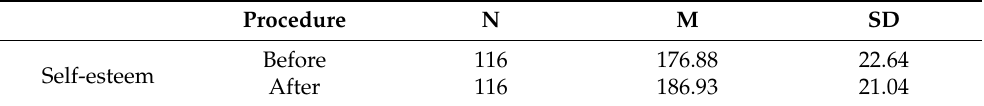
Table 1. Descriptive statistics of the subjective assessment of the patient’s own body before and after the procedure.